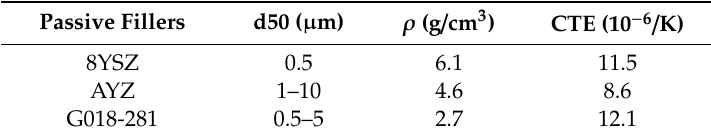
Table 2. Basic properties of filler materials.